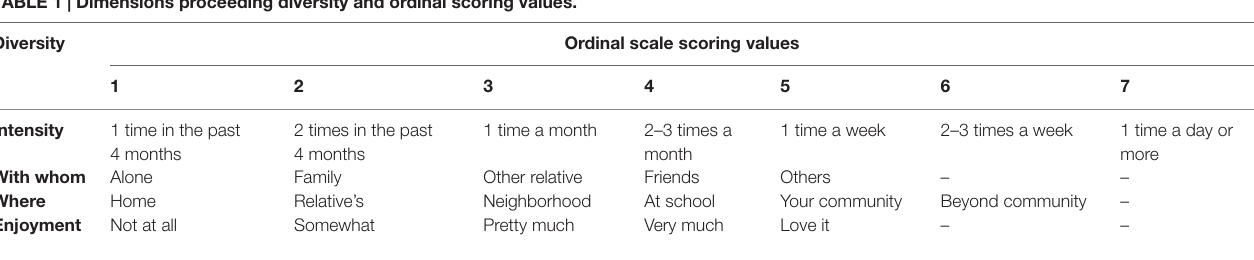
TaBle 1 | Dimensions proceeding diversity and ordinal scoring values.